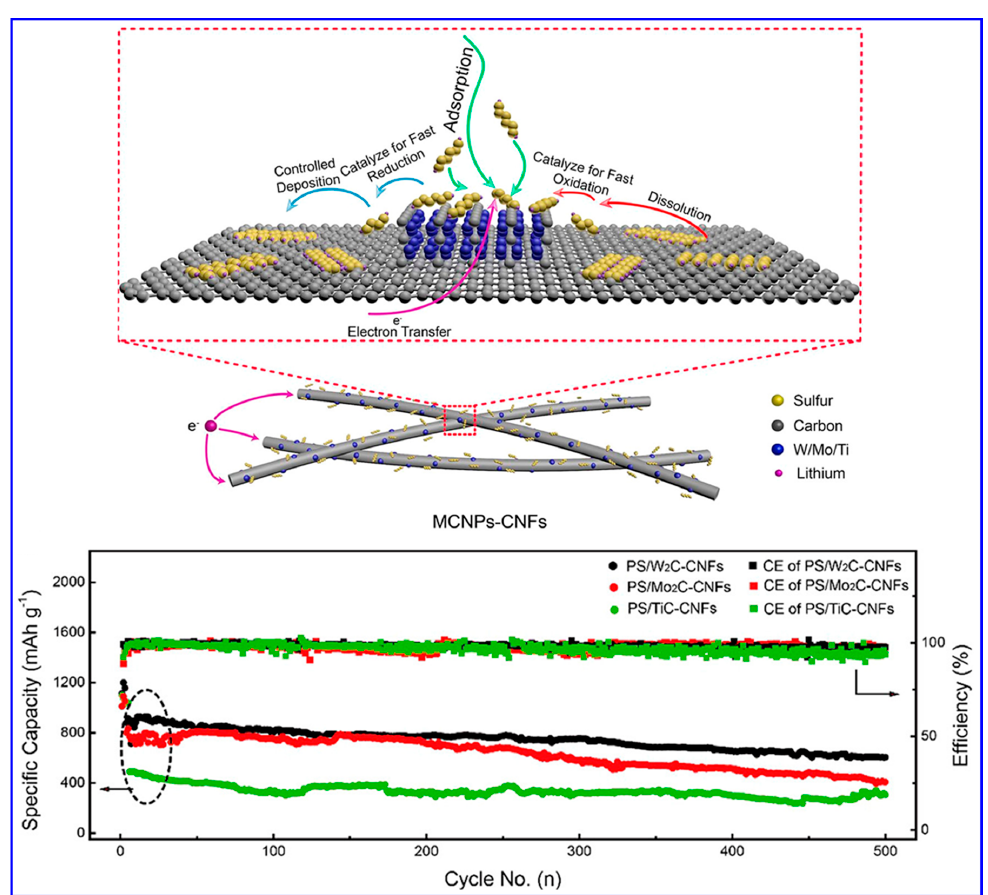
Figure 9. Top: Illustration of MCNPs–CNFs hybrid electrodes functioning; Bottom: comparison of cycling performance of the hybrid electrodes and other control electrodes at 0.2 C rate. Reproduced